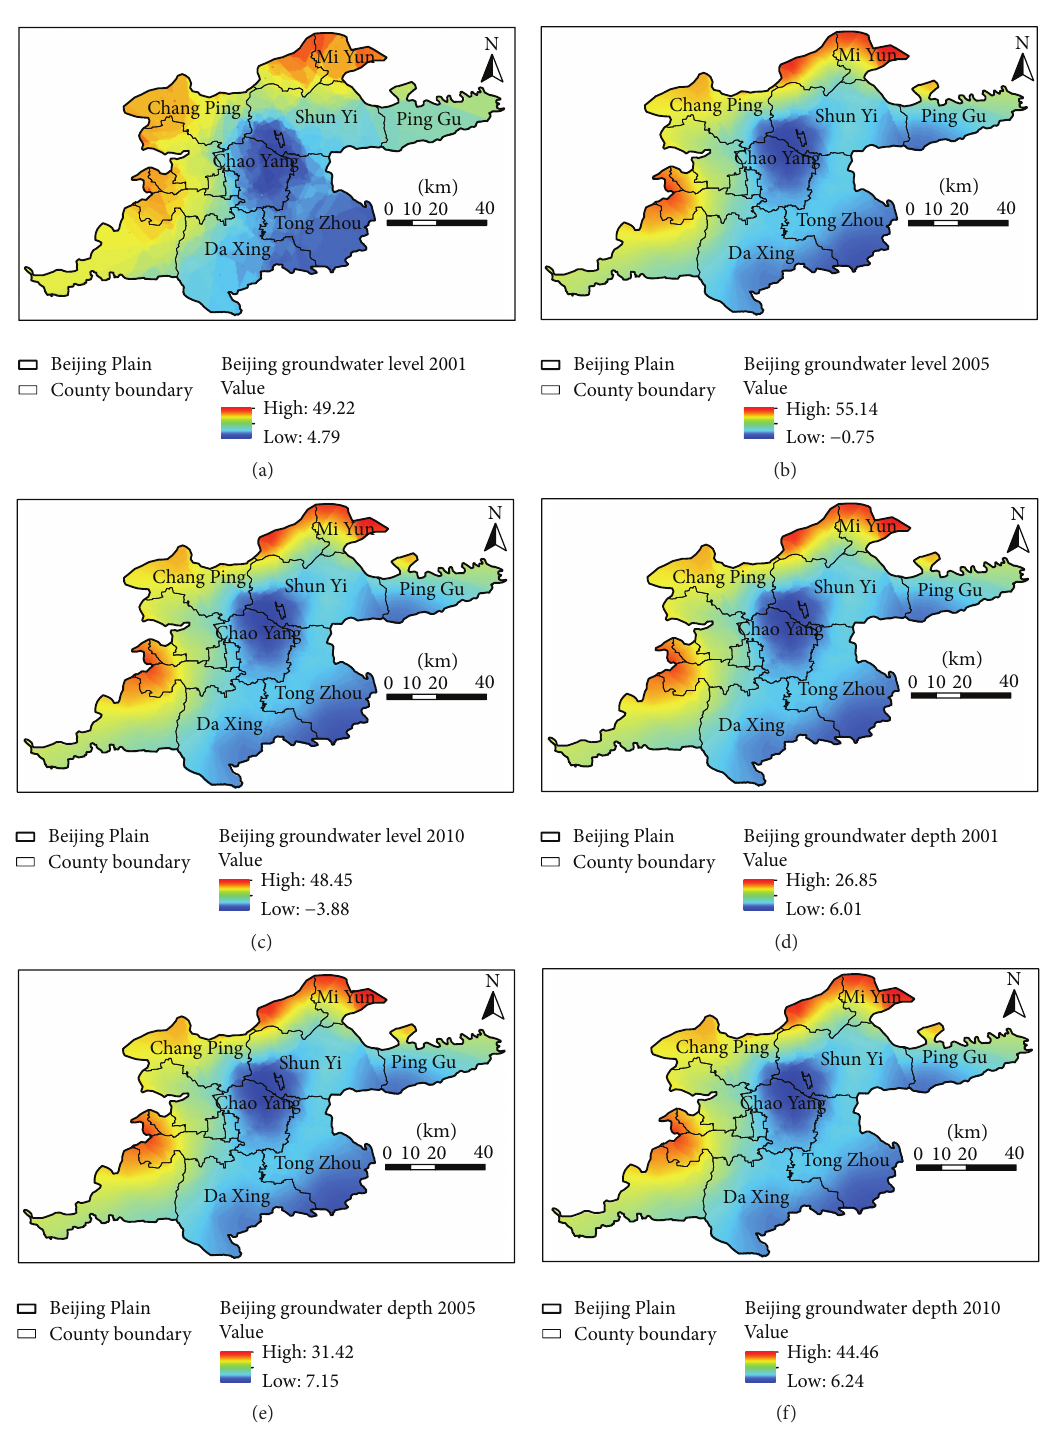
Figure 4: Distribution of groundwater depth/level (m) in Beijing Plain: (a) groundwater depth in 2001, (b) groundwater depth in 2005, (c) groundwater depth in 2010, (d) groundwater level in 2001, (e) groundwater level in 2005, and (f) groundwater level in 2010.